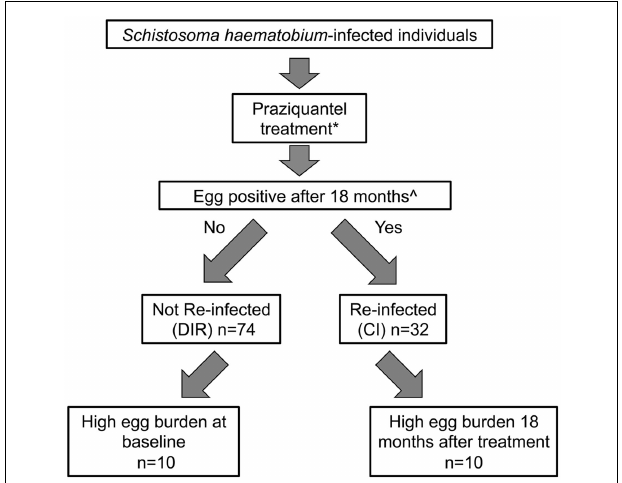
FIGURE 1 | Characterization of study cohort and sub-cohort used for the study described herein . *Treatment efficacy was assessed by urinalysis 6weeks after praziquantel therapy – all subjects were egg-negative (no eggs found in any of three urine samples, each collected on a separate day). ^ Subjects remained in the endemic study area and had regular water contact for the study